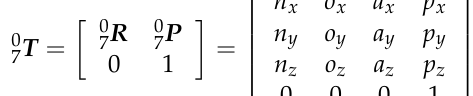
Figure 3. Planar four-bar mechanism.